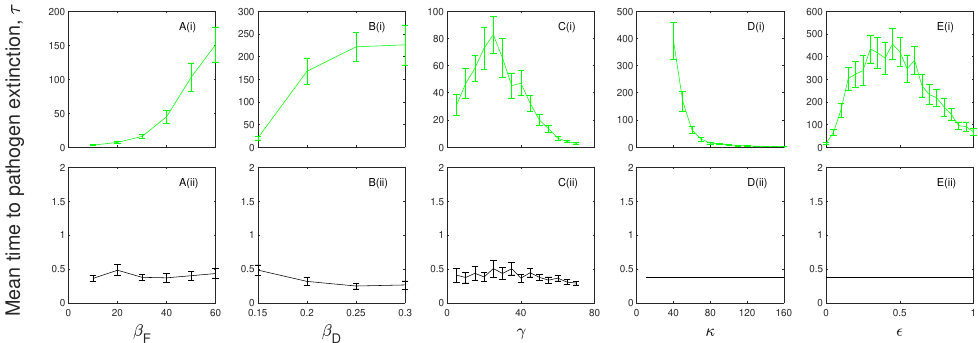
Figure 3. A parameter sensitivity analysis for ( i ) the SIS (black) and ( ii ) the SEIS (green) model frameworks with α = 80. The mean time to pathogen extinction (with 95% confidence intervals) is plotted against ( A ) the frequency-dependent transmission rate, β F ; ( B ) the density-dependent transmission coefficient, β D ; ( C ) the infected recovery rate, γ ; ( D ) the exposed progression rate, κ ; and ( E ) the exposed infectiousness, (cid:101) . When not changed in the figure baseline parameter values were used (see Table 2). Note, at low, α = 10, and medium, α = 40 levels of disease-induced mortality the mean extinction time of the infection for the SEIS model exceeds our simulation time scale and so results are not shown. Results for the SIS model at α = 40 are shown in Figures 5 and